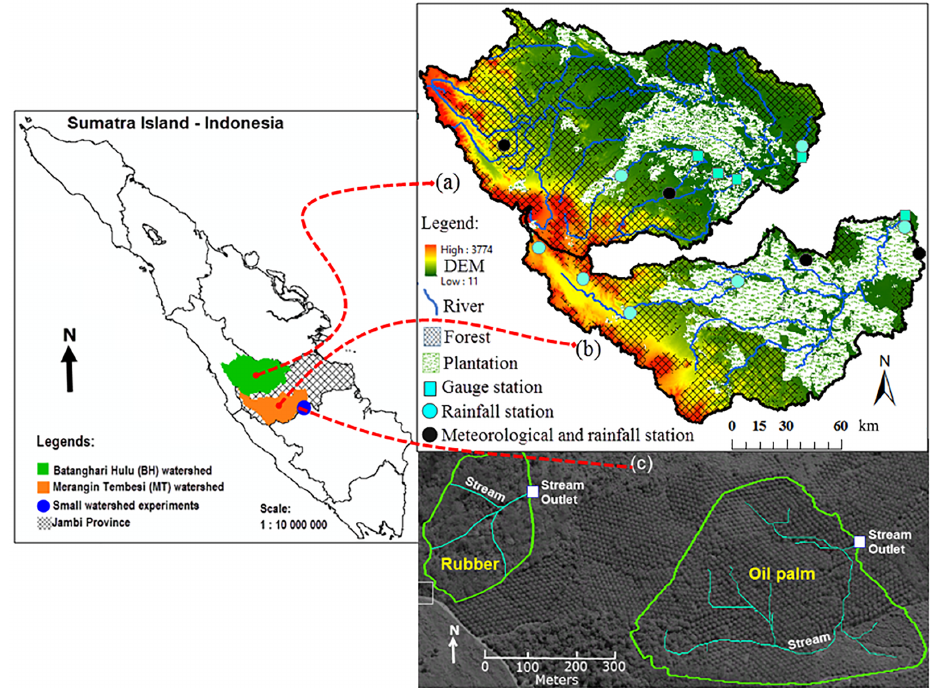
Figure 1. Locations of the (a, b) macro and (c) small watershed experiments in Jambi Province, Sumatra,